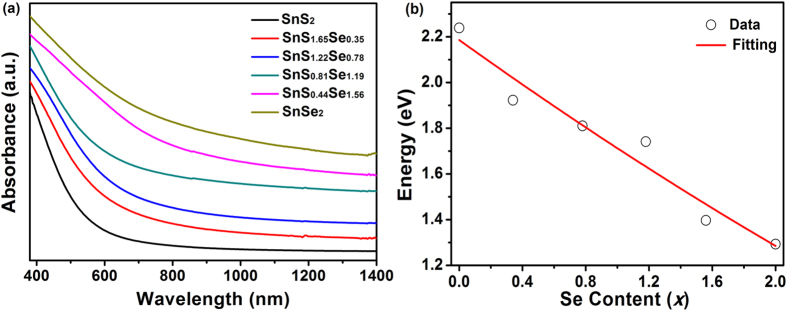
(a) UV-vis-NIR absorption spectra and (b) composition-dependent band gaps and the corresponding fitting curve of SnS2−xSex alloys.